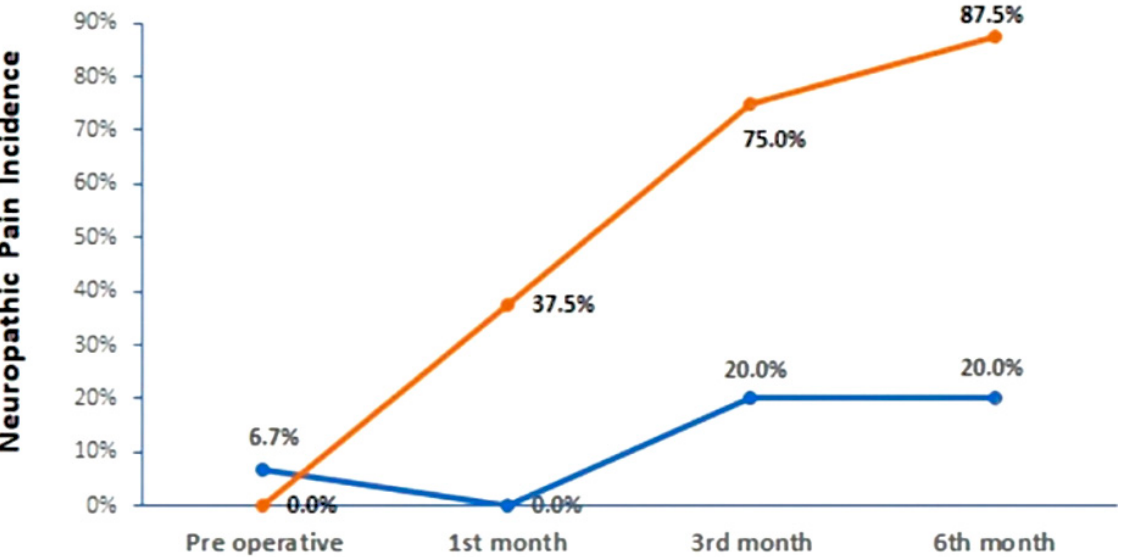
Figure 2. Evolution of neuropathic pain incidence on the groups of patients negative and positive for Cutibacterium acnes . Frequency of Isolated Phylotypes. Table 5. Neuropathic Pain Evaluation (DN4 Score).